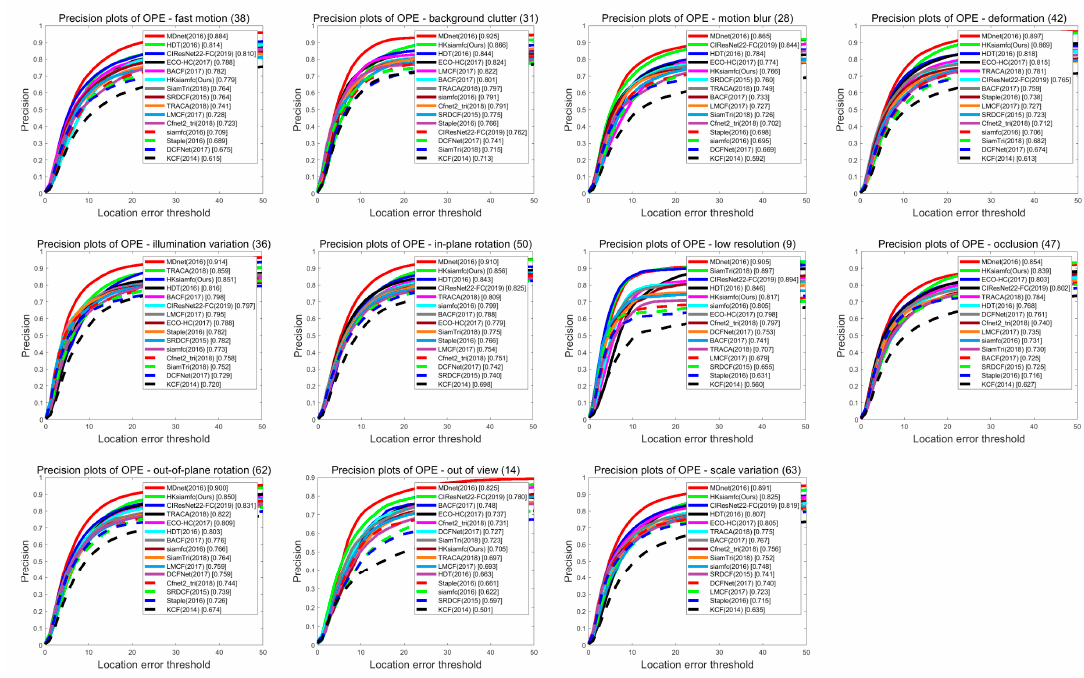
Figure 9. Tracking result of 15 compared trackers in precision plot in 11 different scenarios. This picture is best viewed on high-resolution displays.